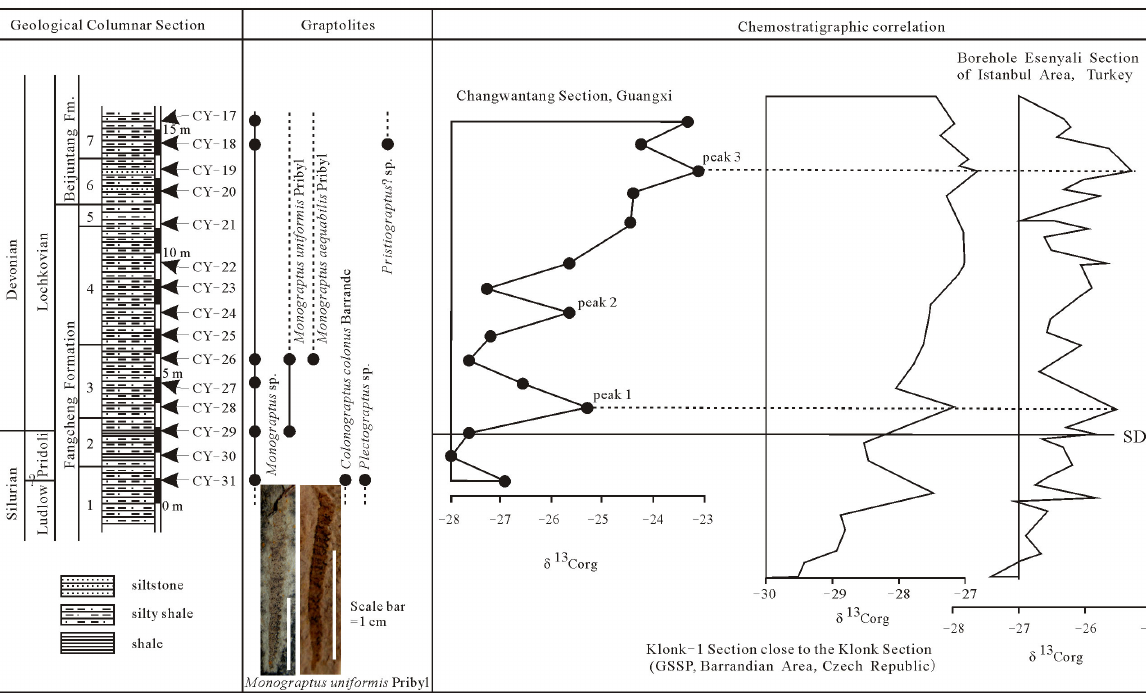
Fig. 3. Chemostratigraphic correlation of the isotopic variation in organic carbon between the Klonk-1 Section close to the GSSP, the Borehole Esenyali Section and the Changwantang Section with new graptolite